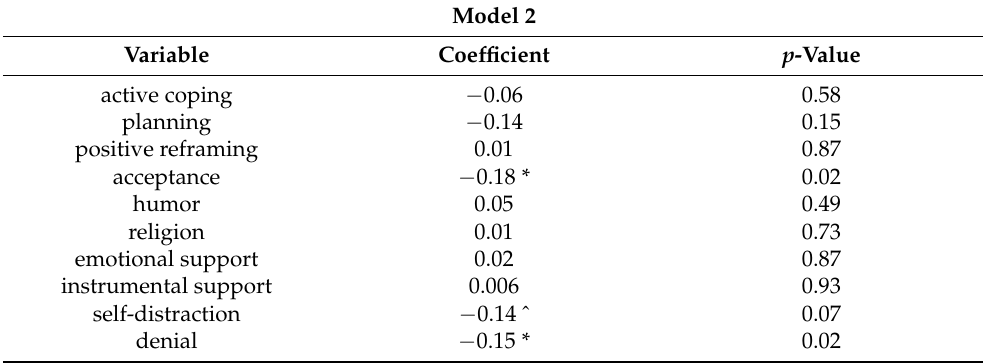
Table 4. Results of logistic